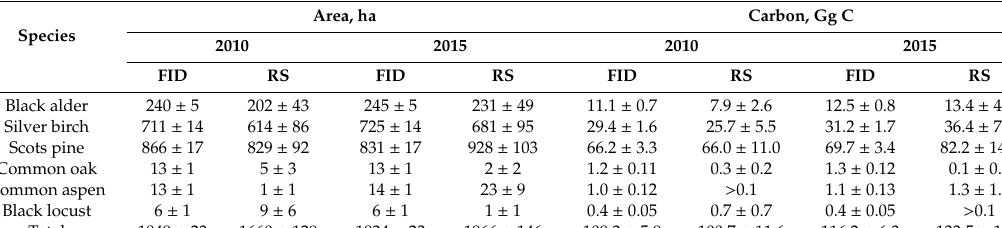
Table 8. Tree species distribution: Forested area and carbon stock, 2010–2015. FID: forest inventory database; RS: remote sensing.